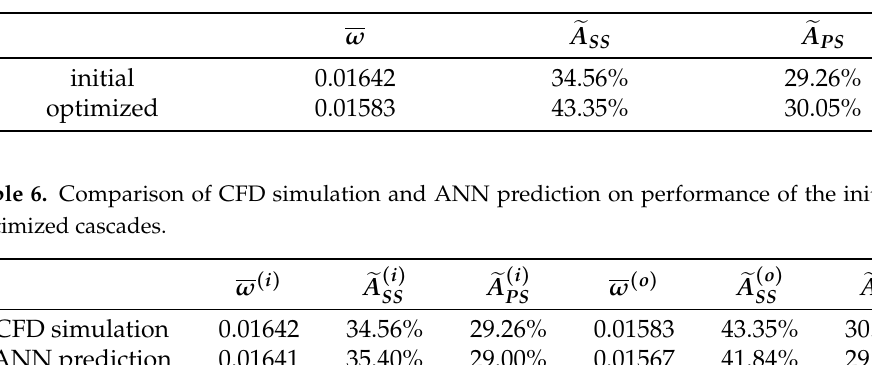
Table 5. Performance characteristics of the cascades at the operating point.